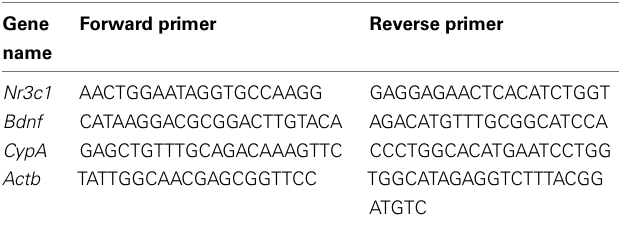
Table 4 | Primers for gene expression analyses.